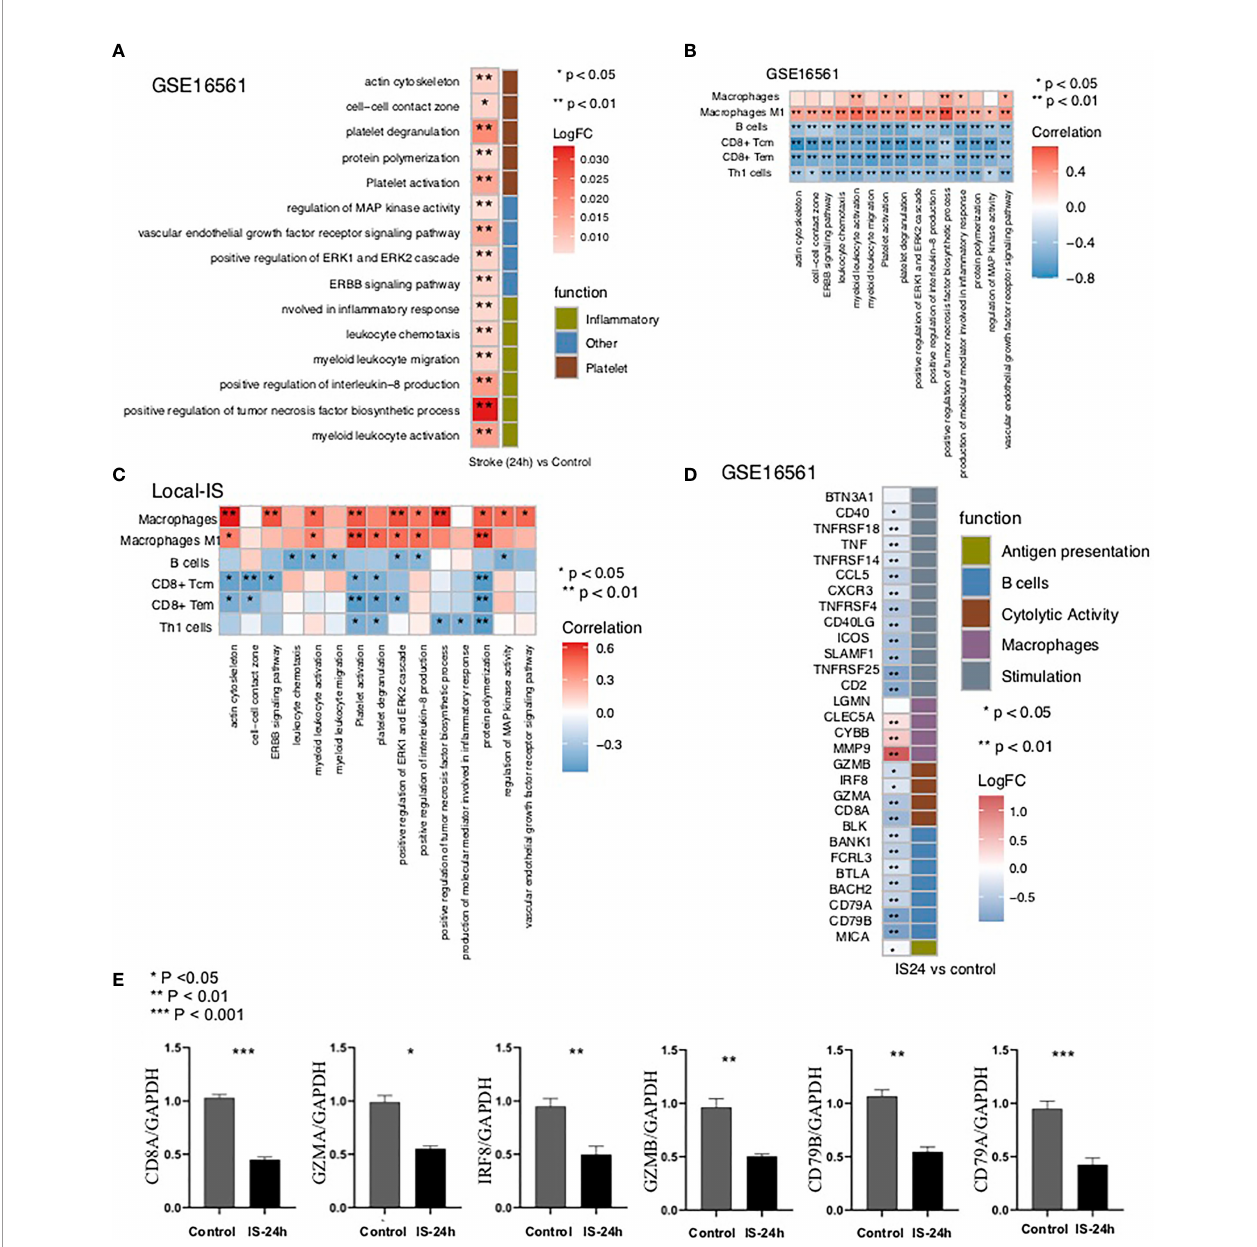
FIGURE 5 | The result of ssGSEA. (A) Heatmap depicting the mean differences in ssGSEA scores for several signaling pathways between the IS-24h and control groups in GSE16561. The y axis indicates the in fl ammation-related, platelet-related, and pathological pathways. Each square represents the fold change or difference in the ssGSEA score for an in fl ammation-related, platelet-related, or pathological pathway between the IS-24h and control groups. Red indicates upregulation, while blue indicates downregulation. (B) Correlation analysis of the scores of different immune cells estimated by the xCell algorithm and the ssGSEA scores for signaling pathways in GSE16561. (C) Correlation analysis of the scores for different immune cells estimated by the xCell algorithm and the ssGSEA scores for signaling pathways in the Local-IS cohort. (D) Heatmap depicting the mean differences in the mRNA expression of immune-related genes between the IS-24h and control groups in GSE16561. The y axis indicates the immune signature or gene compared between the IS-24h and control groups in GSE16561. Each square represents the fold change or difference in each indicated immune signature or gene between the IS-24h and control groups. Red indicates upregulation, while blue indicates downregulation. (E) Expression pro fi le of CD8A, GZMA, IRF8, GZMB, CD79B and CD79A between IS-24h and control groups in Local-IS (qPCR). *P < 0.05; **P < 0.01; ***P <